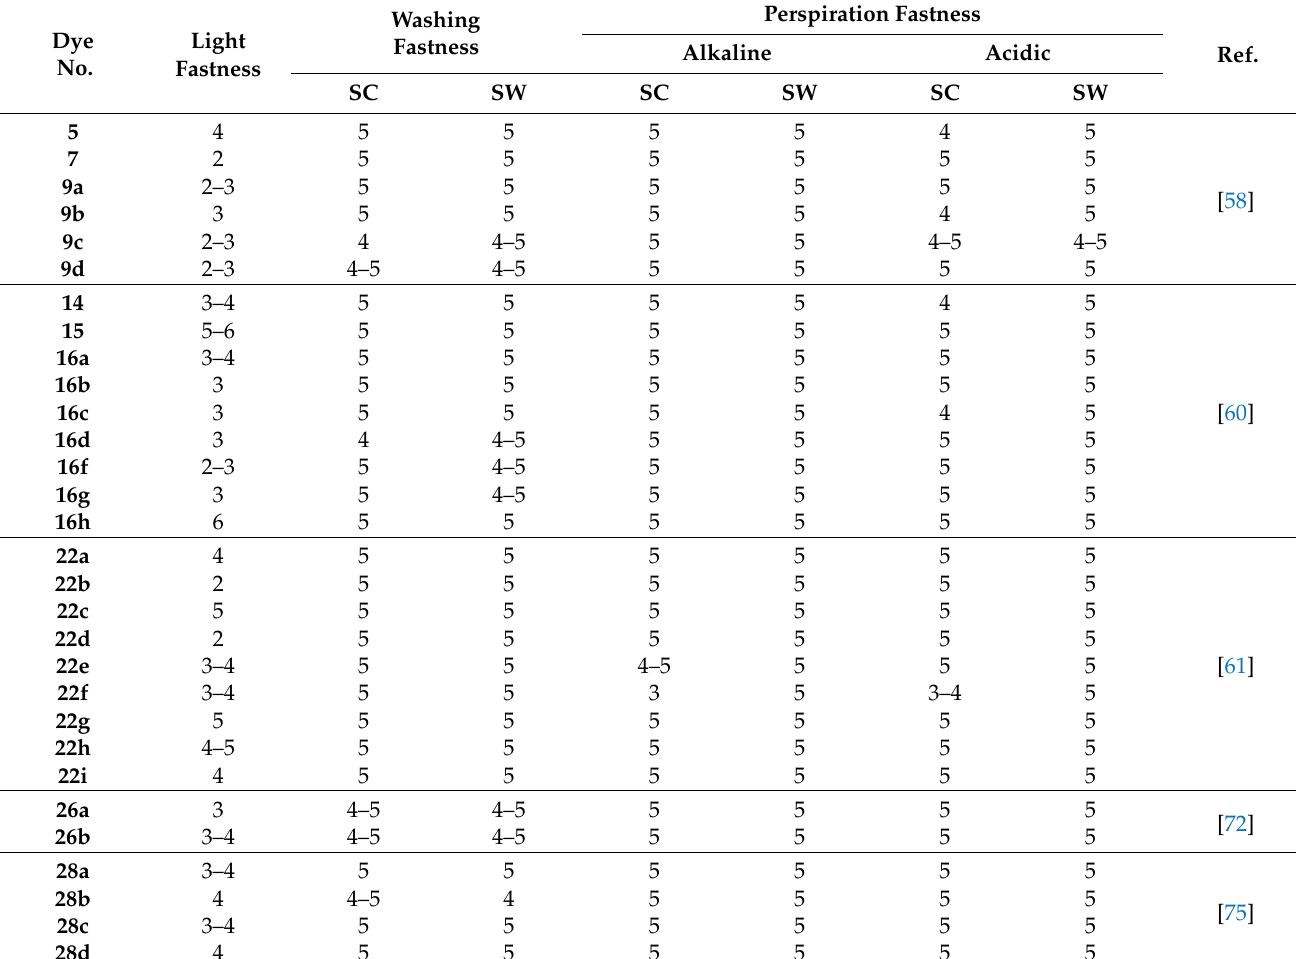
Table 3. Fastness properties of the polyester dyed fabrics with 2% shades of disperse